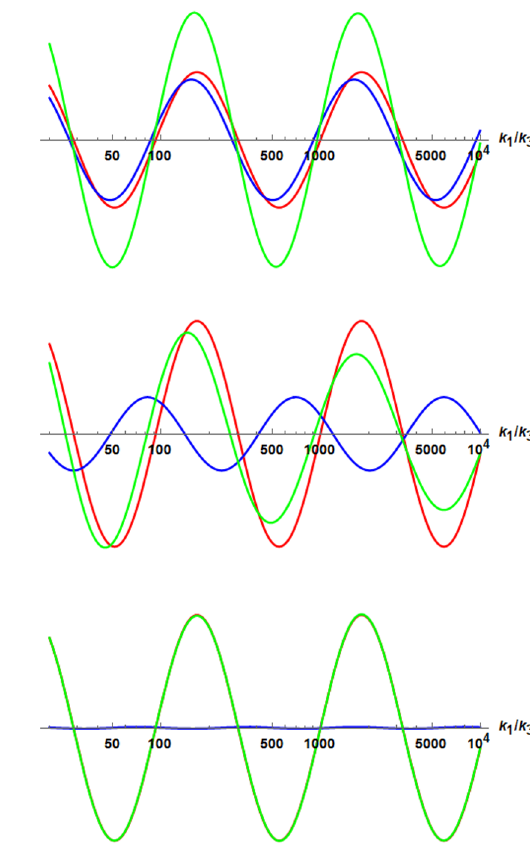
= ˜ g = 1 for I = 1 , 2 . II II = 2 . 5 , the red and the green 2 /H